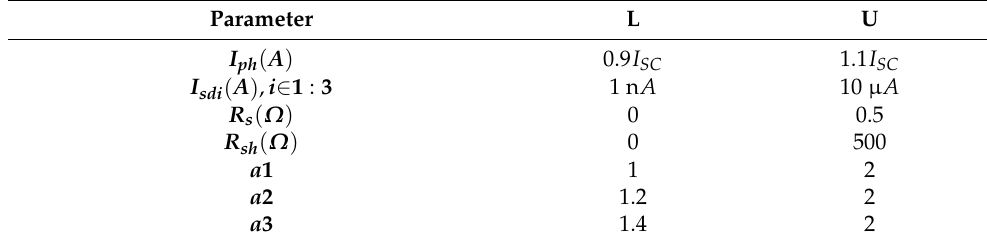
Table 2. Search ranges of nine parameters.